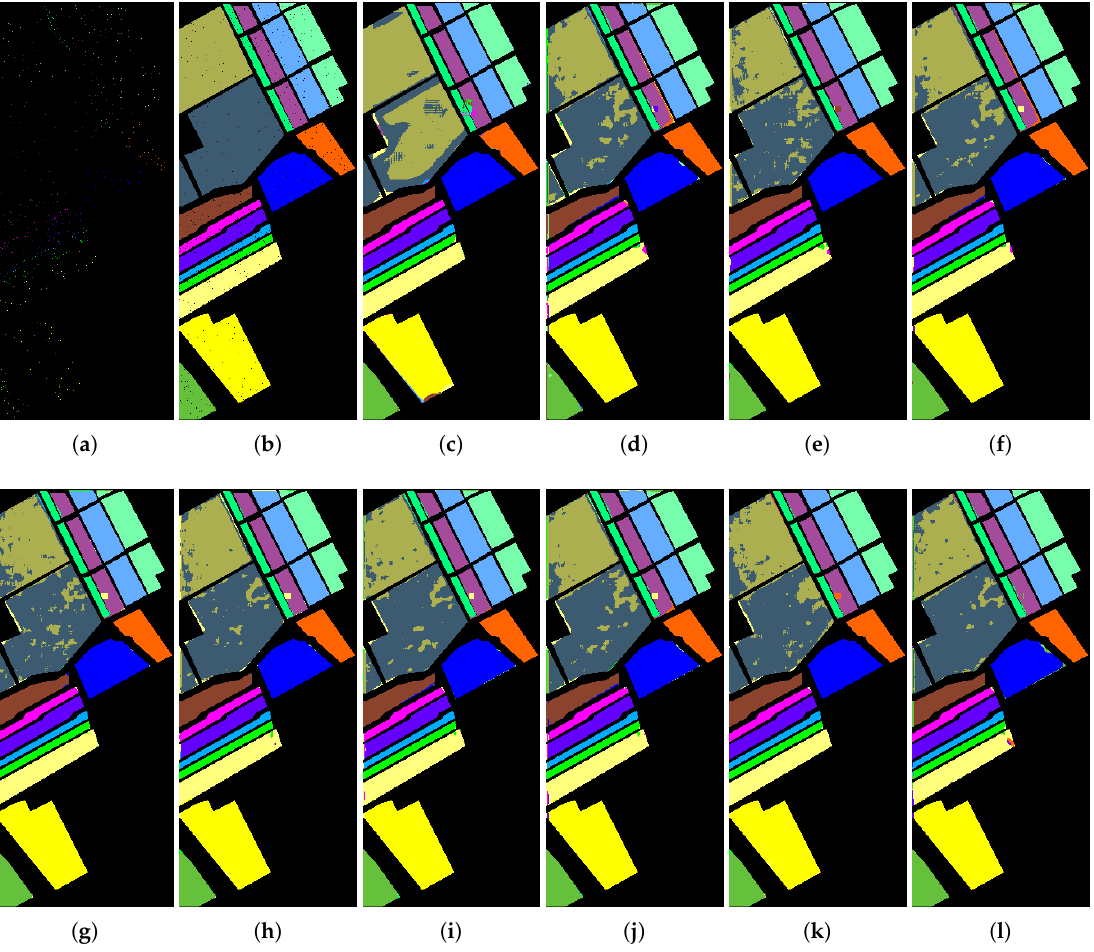
Figure 10. Classification maps of different DR models based on SVM on the Salinas data: ( a ) Training GT; ( b ) Testing GT; ( c ) CNN (OA = 84.2%); ( d ) SVM (OA = 93.2%); ( e ) SPPCA (OA = 94.7%); ( f ) NWFE (OA = 94.0%); ( g ) DGPLVM(OA = 94.1%); ( h ) SLGDA (OA = 94.1%); ( i ) LapCGDA (OA = 94.2%); ( j ) KCGDA (OA = 94.1%); ( k ) LGSFA (OA = 94.2%); and ( l ) GPGDA (OA =